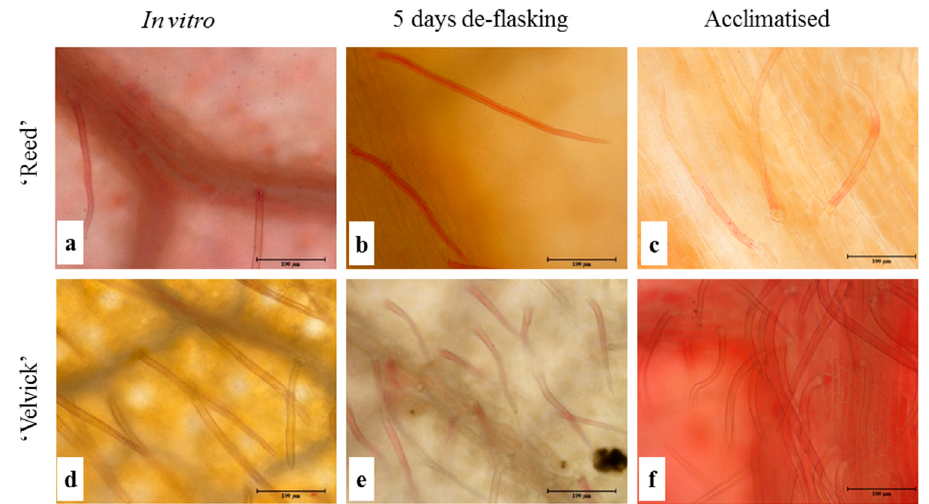
rootstocks, the progression from in vitro to acclimated stage increased the trichome density